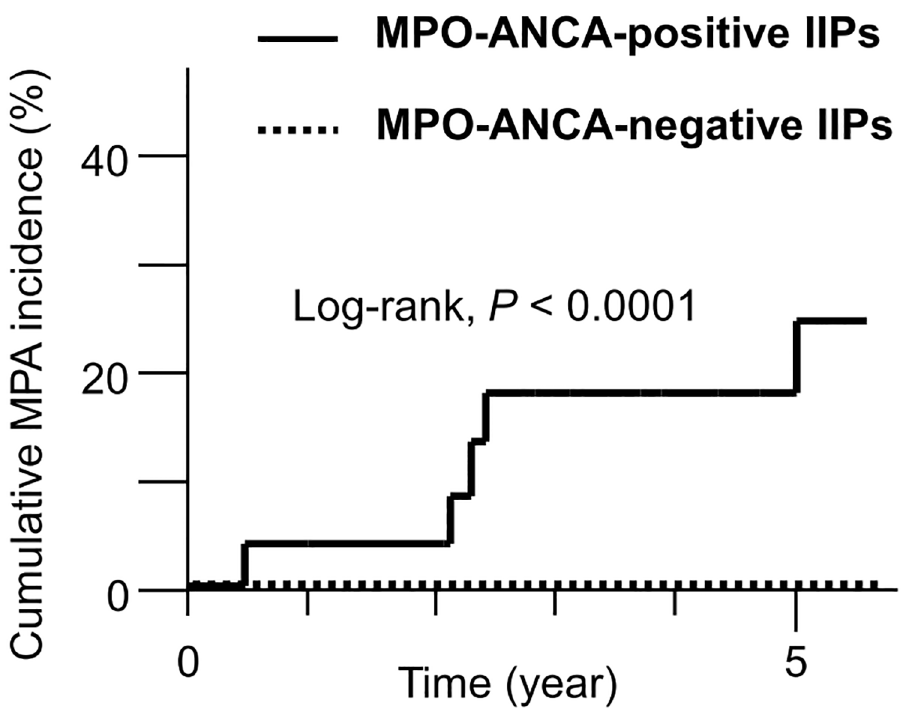
Fig 2. Cumulative MPA incidence in MPO-ANCA-positive and -negative IIP patients. The 5-year MPA incidence was 24.3% in the MPO-ANCA-positive IIP patients and 0% in the MPO-ANCA-negative IIP patients. P < 0.0001 by log-rank test. IIPs, idiopathic interstitial pneumonias; MPA, microscopic polyangiitis; MPO-ANCA, myeloperoxidase- anti-neutrophil cytoplasmic antibody.